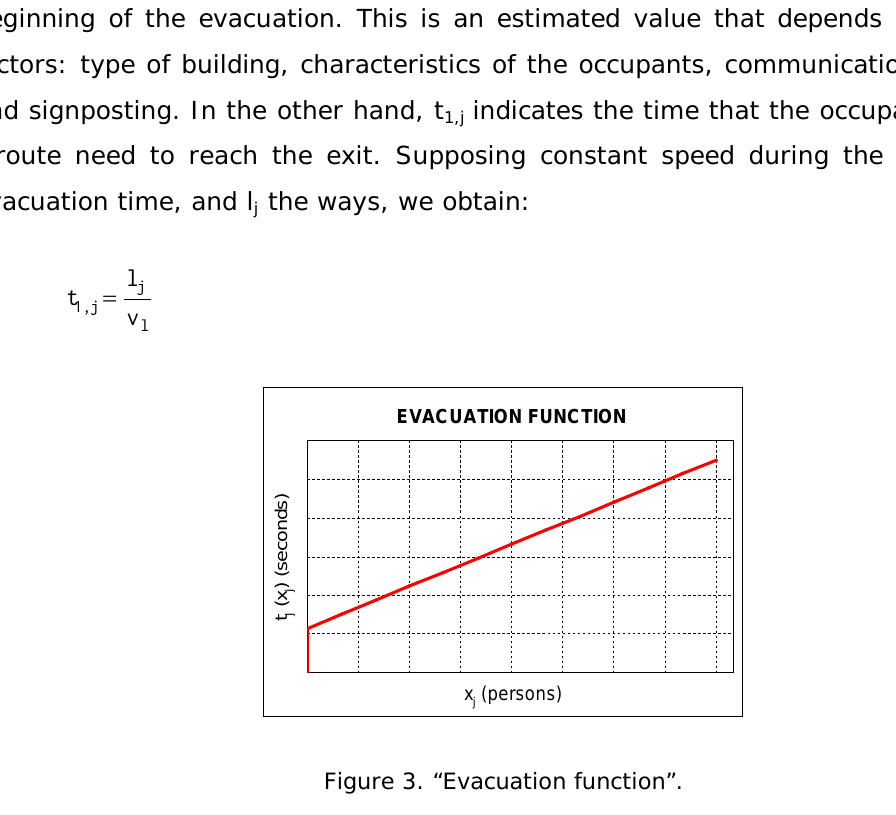
Figure 3. “Evacuation